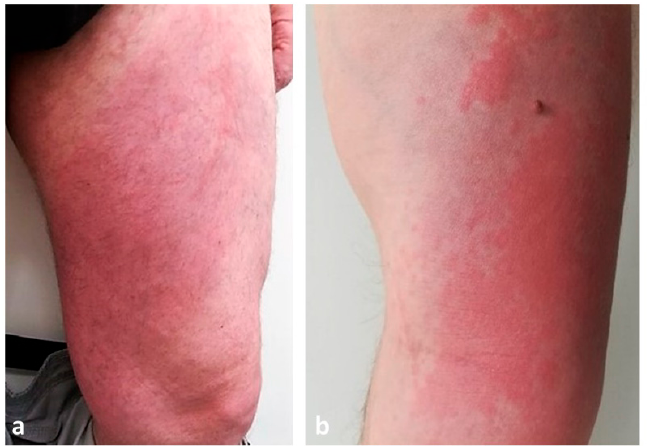
Figure 6. Clinical presentation of Wells syndrome showing erythematous, edematous and infil- trated plaques on lower ( a ) and upper limbs ( b ). plaques on lower ( a ) and upper limbs ( b